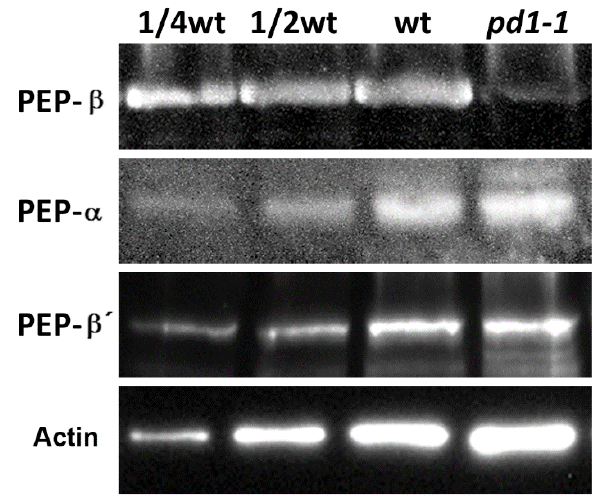
Figure 9. Accumulation of PEP- β subunit is defective in the pd1-1 mutant. Total leaf protein prepared from wild type and pd1-1 seedlings was separated by SDS–PAGE electrophoresis and analyzed by immunoblot with specific antibodies for PEP- β . Accumulation of PEP- α and PEP- β′ was examined parallelly. Accumulation of A ctin was the reference of the loading sample.